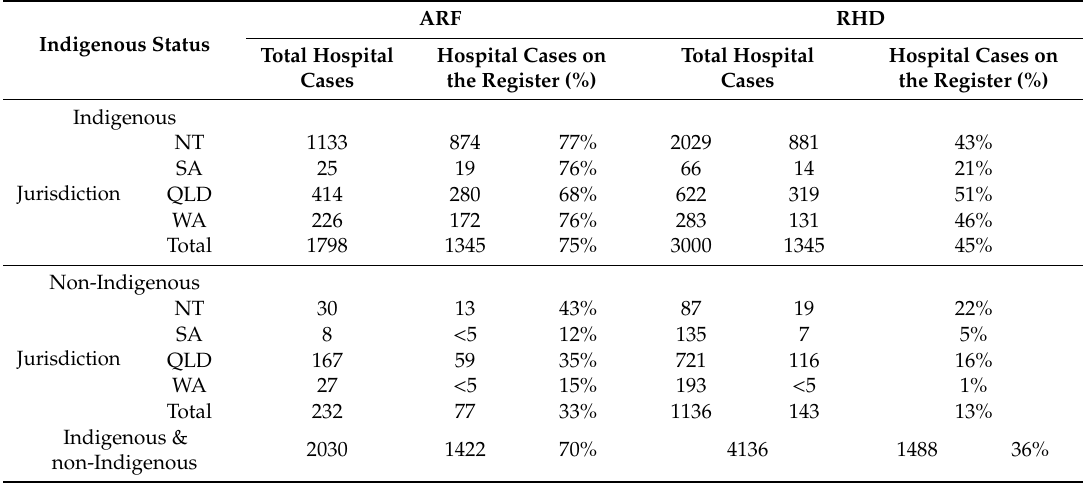
Table 2. Count and percentage of hospital diagnosed ARF / RHD cases recorded on ARF / RHD registers by Indigenous status and